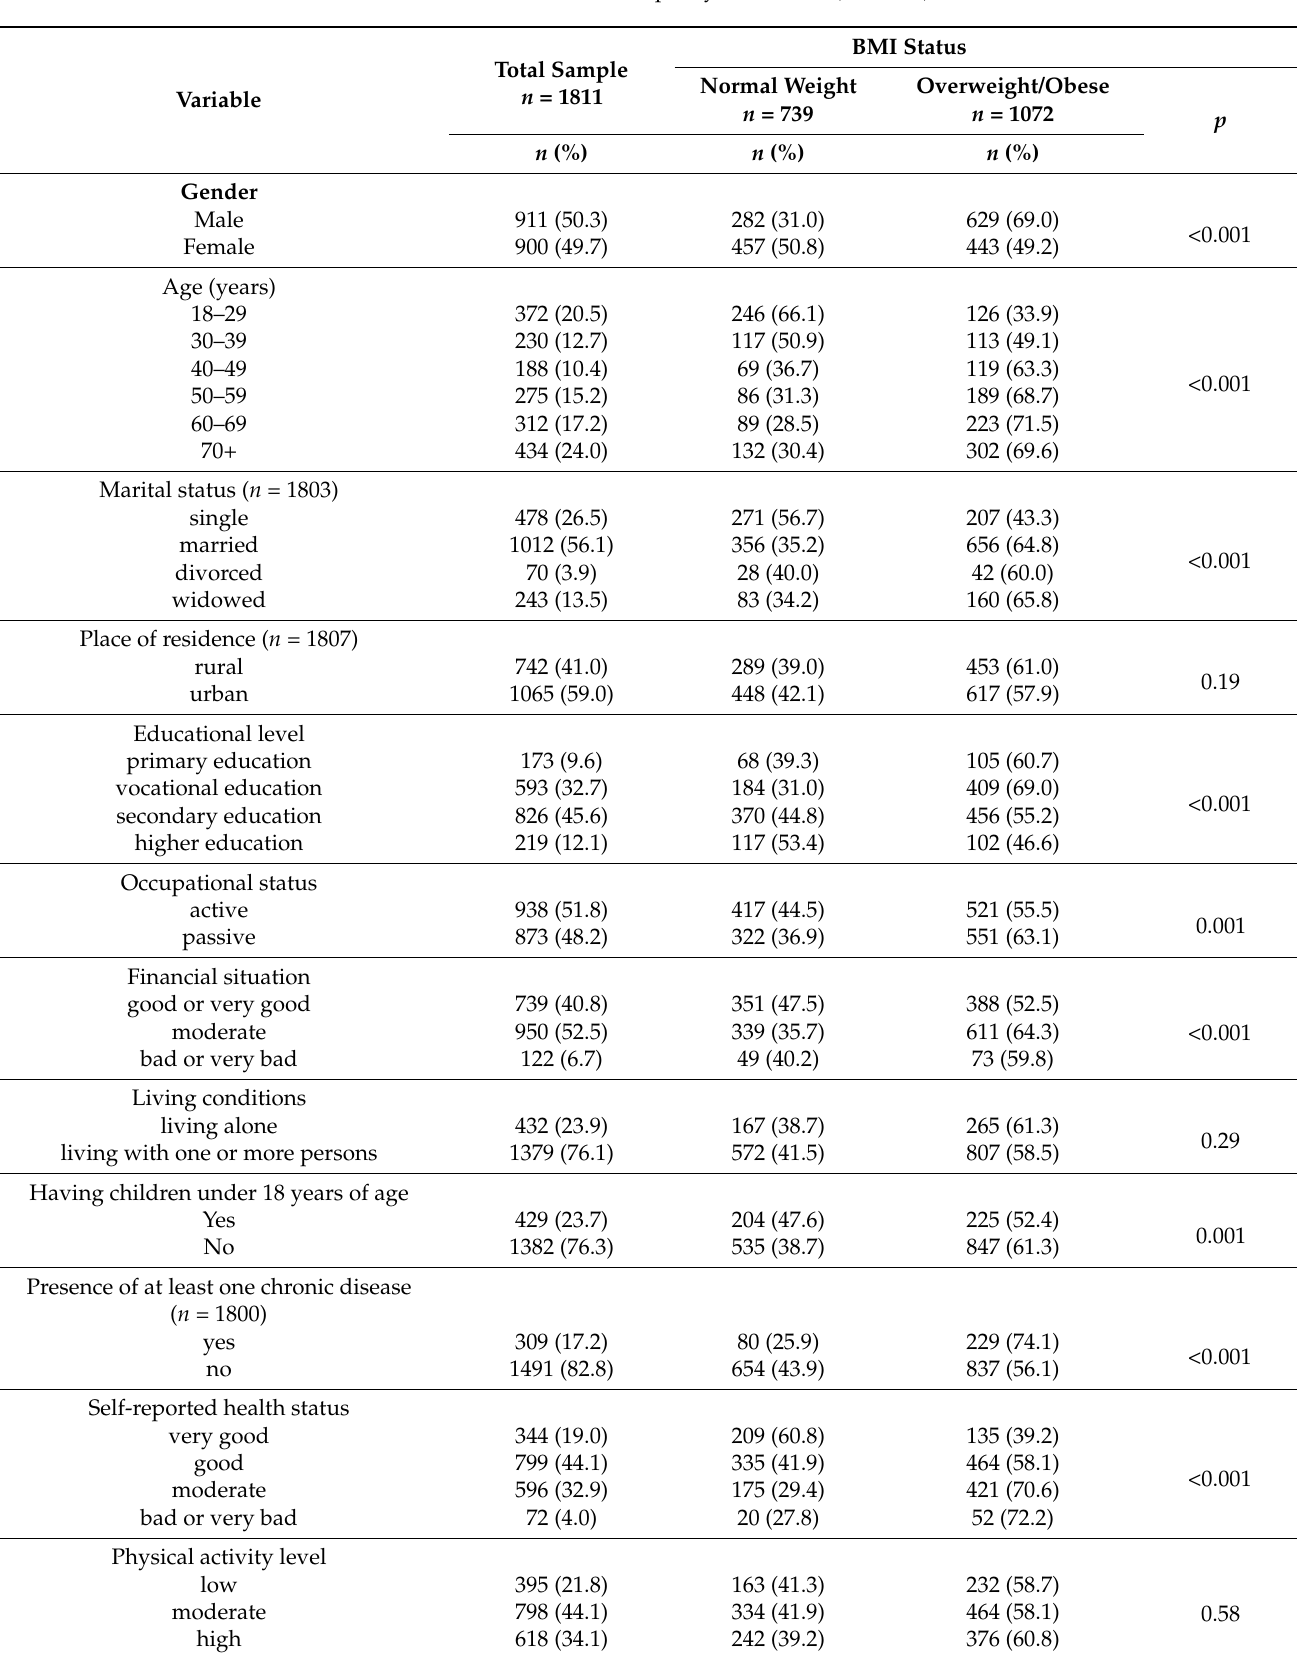
Table 1. Characteristics of the sample by BMI status ( n =